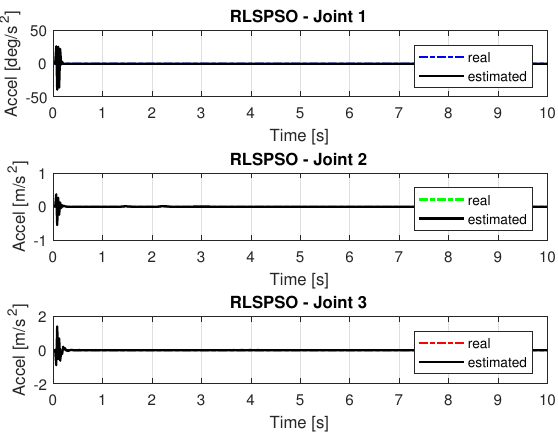
Figure 20. Accelerations of joints with RLSPSO.